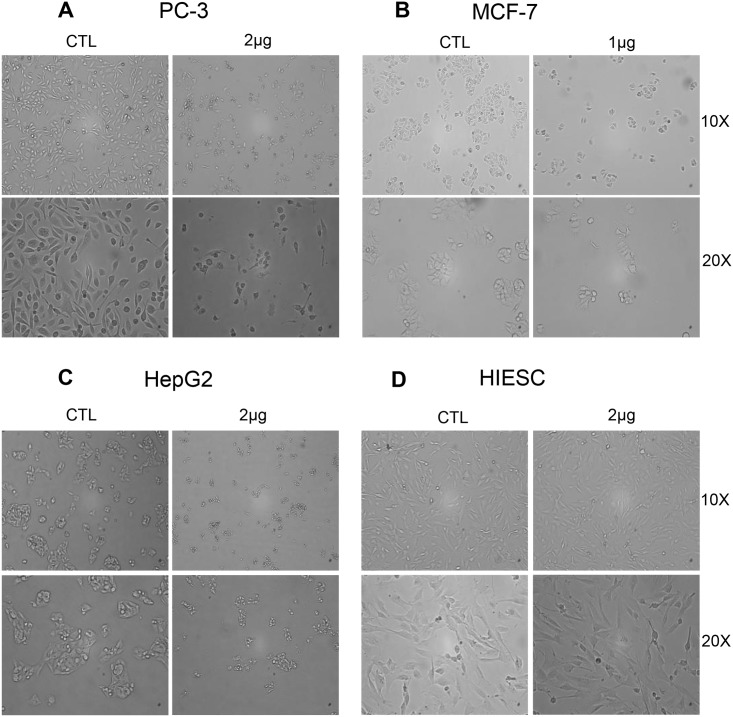
Morphological characteristics of cells following Bacillus thuringiensis 4R2 toxin proteins treatment.PC-3 (A), MCF-7 (B), HepG2 (C) and HIESC (D) cells were treated with 1μg/mL or 2μg/mL B. thuringiensis 4R2 toxin proteins for 24h. After 24h, the cells were observed by light microscopy at a magnification of 10X and 20X. Results shown are representative of three independent experiments.